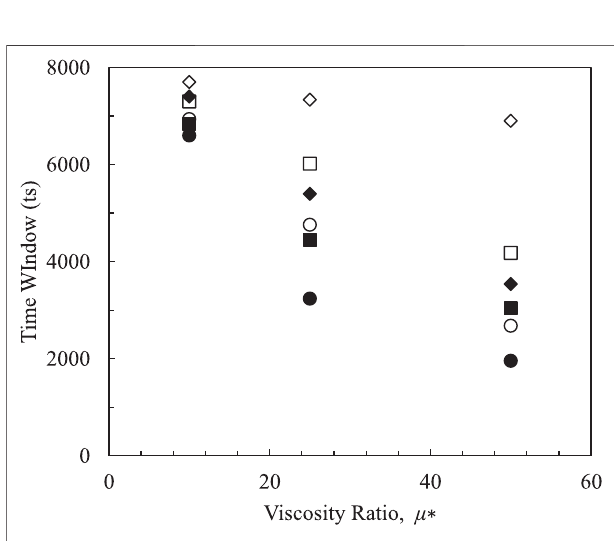
FIGURE5 | Effects of viscosity ratio μ * on time windows: solid symbols represent large droplets ( R (cid:1) 25 lu) and empty symbols stand for small droplets ( R (cid:1) 15 lu), respectively; diamond ( σ (cid:1) 1 × 10 − 4 mu/ts 2 ), squares ( σ (cid:1) 2 × 10 − 4 mu/ts 2 )and circles( σ (cid:1) 2.5e-4 mu/ts2) represent threespeci fi ed surface tensions, respectively.